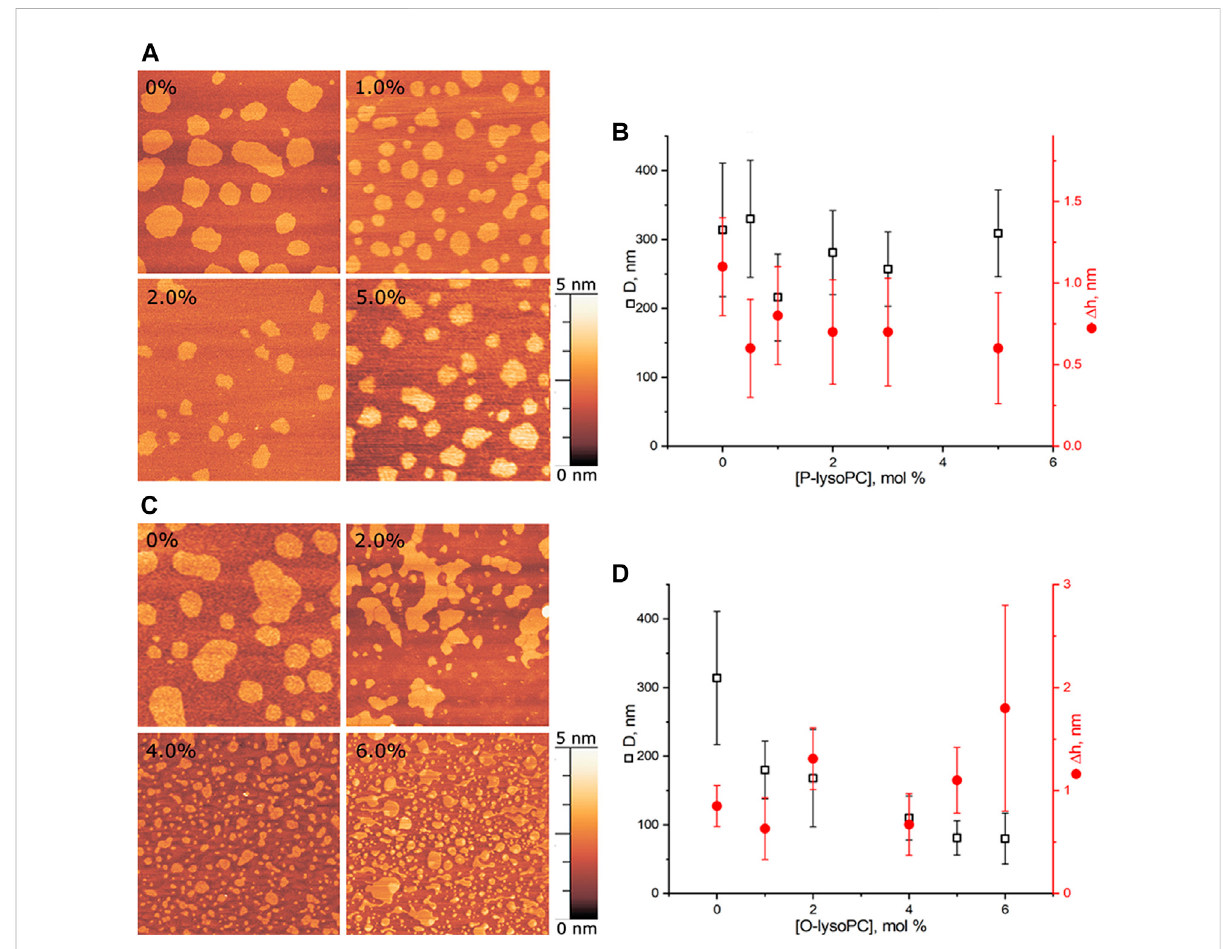
FIGURE 2 LysolipidsintheeSM/DOPC/Chol=2:2:1membrane. (A) AFMimagesofthemembranewithP-lysoPC. (B) Dependenceoftheaveragediameter of rafts on the molar fraction of P-lysoPC in the membrane. (C) AFM images of the membrane with O-lysoPC. (D) Dependence of the average diameter of rafts (black) and their height above the surrounding membrane (red) on the molar fraction of O-lysoPC in the membrane. Size of each AFM image is 3 μ m × 3 μ m. Amount of lysolipids in the membrane in mol% is indicated in each